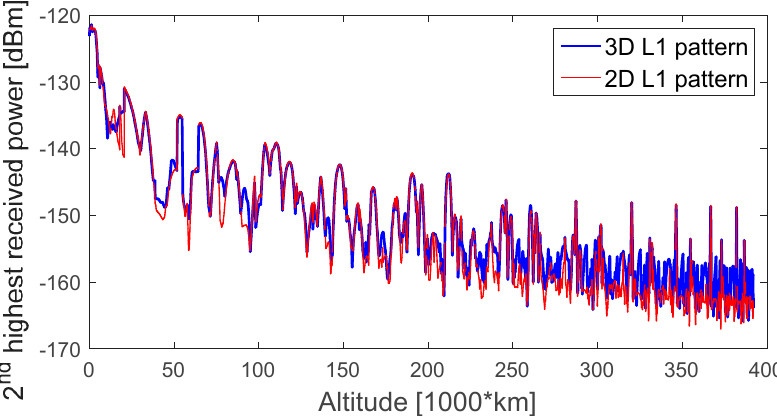
Figure 7. Second-highest received power level of GPS L1 signals, during the considered MTO, for a 0 dBi receiver gain pattern.